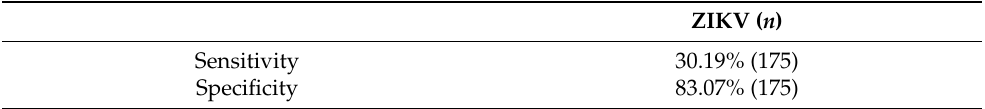
Table 6. Specificity and sensitivity values comparing the custom peptide-based ELISA to microneu- tralization assays for uncharacterized Guatemalan